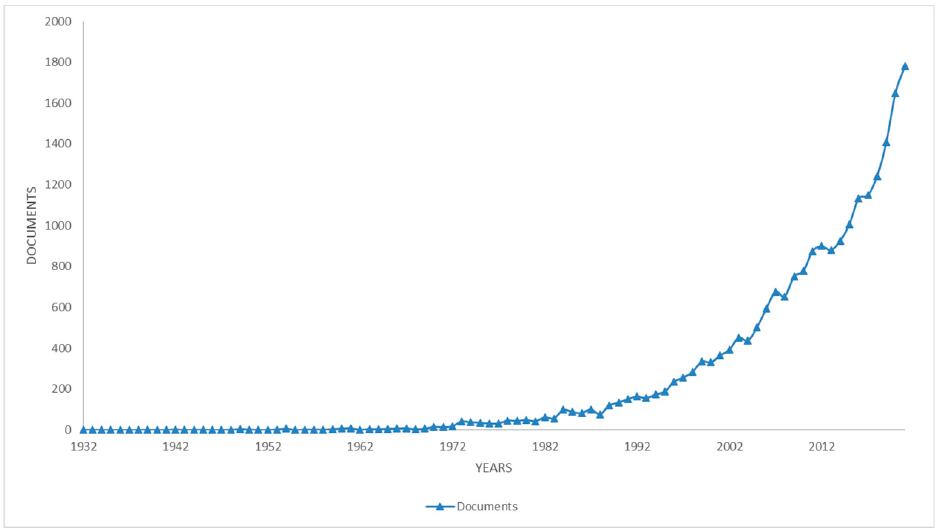
Figure 2. Publication trend (1932–2021) of the seafood/fish/nutrient/bioactive compound search. (Based on data from Scopus).